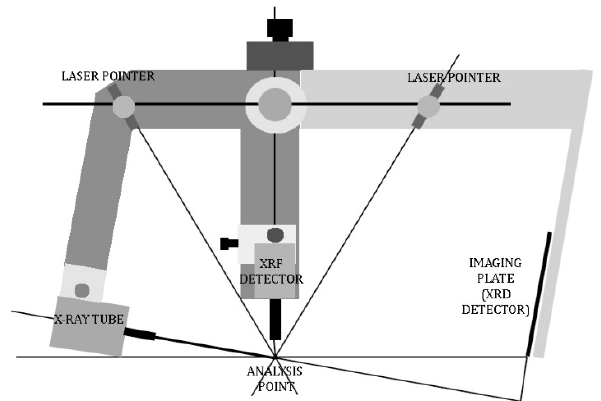
Figure 3. Experimental system of the prototype developed by the C2RMF to analyze simultaneously elemental chemical analysis (XRF) and crystallographic structure identification